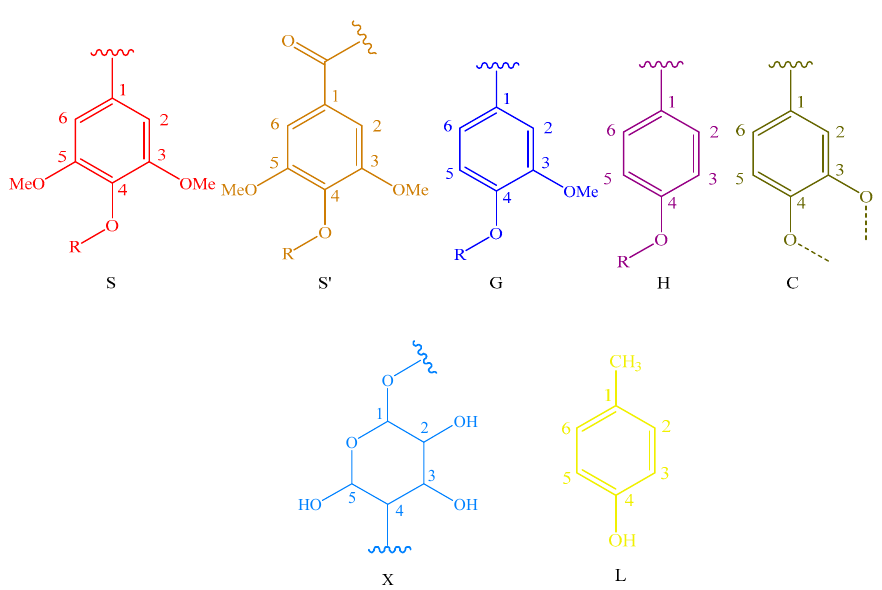
Figure 6. Main classical structures in the lignin preparations: ( A ) lignocresol; ( A’ ) β - O -4 alkyl-aryl ethers with acylated γ -OH with p -coumaric acid; ( B ) resinol structures formed by β - β / α - O - γ / γ - O - α linkages; ( IC ) phenylcoumarane structures formed by β -5/ α - O -4 linkages; ( D ) benzodioxane substructures; ( F ) p -hydroxycinnamyl alcohol end-groups; ( F’ ) p -hydroxycinnamyl alcohol end-groups acylated at the γ -OH; ( FA ) ferulates; ( p CA)p-coumarates; ( S ) syringyl units; ( S’ ) oxidized syringyl units bearing a carbonyl at C α ; ( G ) guaiacyl units; ( H ) p -hydroxyphenyl units; ( C ) catechyl units; ( X ) xylopyranoside; and ( L ) p -cresol.